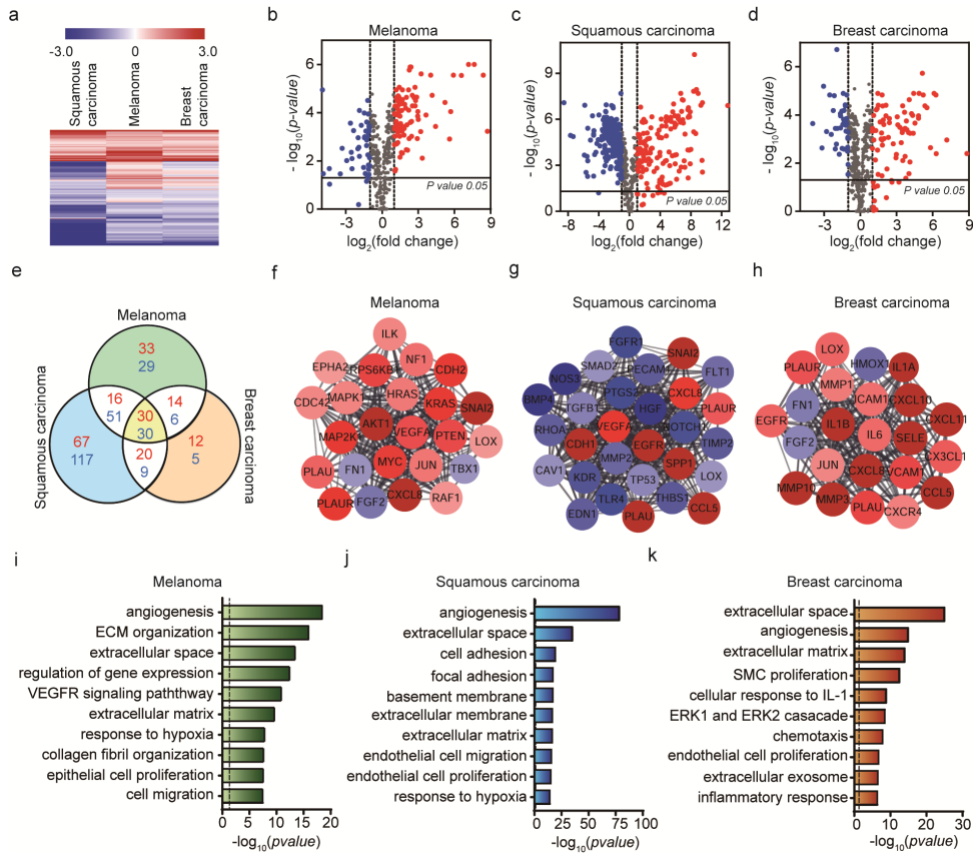
Figure 3. Identification of differentially expressed genes from cCAFs and their biological functions. ( a ) Hierarchical clustering of expression profiles of differentially expressed mRNAs among the three cell lines ( p < 0.05). Red color indicates high relative expression and blue indicates low relative expression. ( b – d ) Volcano plot showing gene expression differences among the three cell lines, with red representing DE genes with log 2 (fold change) > 1 and blue representing DE genes with log 2 (fold change) < − 1. ( e ) Venn diagram showing the significant gene numbers for the three cancer cell lines. Red represents log 2 (fold change) > 1 and blue log 2 (fold change) < − 1. Comparison of DE gene expression levels with cCAFs and HUVECs. ( f – h ) Top module of the protein–protein interaction (PPI) network for densely connected nodes. Red, DE genes with log 2 (fold change) > 1; blue, DE genes with log 2 (fold change) < − 1. Larger node size represents more significant p -values. ( i – k ) Gene ontology (GO) term enrichment analysis of mRNA expression in B16BL6, A431 and MDA-MB-231 cells ( p -value < 0.05, | log 2 (fold change) | > 1). The dashed line signifies a p -value of 0.05.